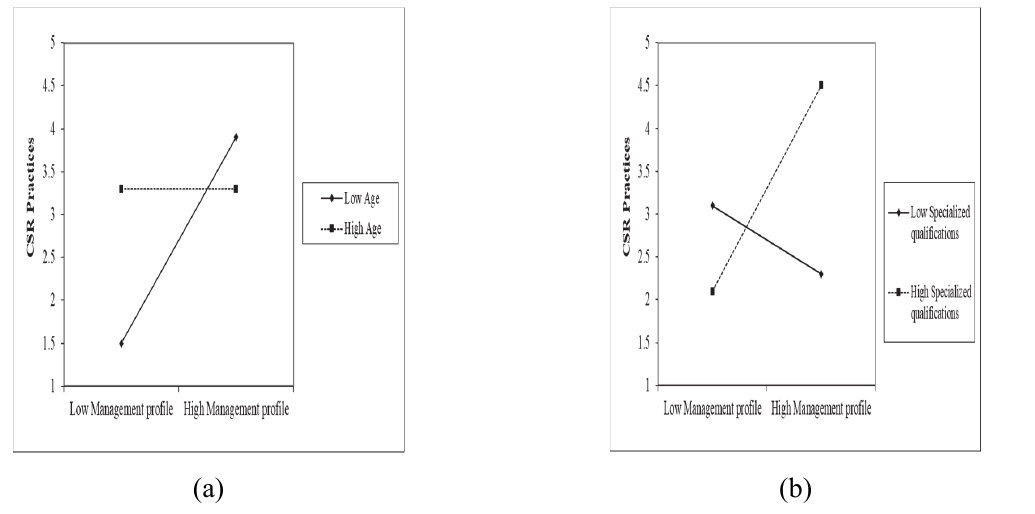
Fig. 5. Moderate role with a: Age; b: Specialized